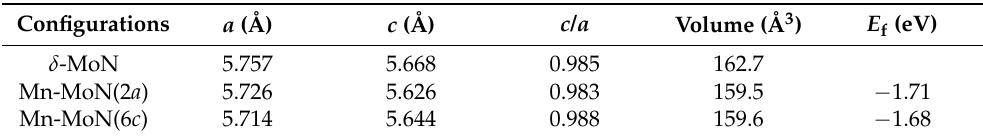
Table 1. Optimized lattice parameters of δ -MoN before and after Mn substitution, and formation energies of Mn-MoN(2 a ) and Mn-MoN(6 c ).